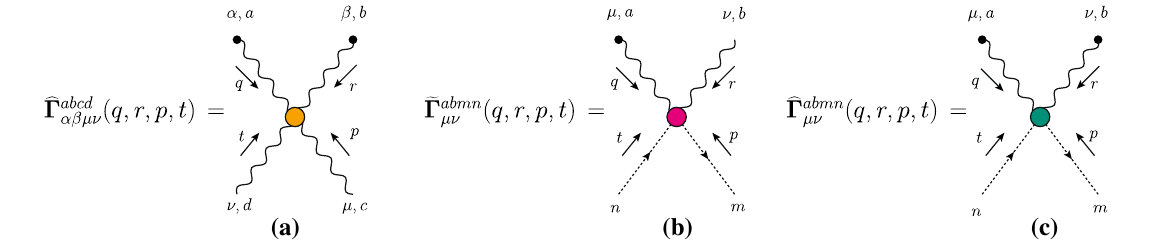
Fig. 2 Diagrammatic representations of the fully dressed four-point functions: a BBQQ, b BQ ¯ cc, and c BB ¯ cc. Notice that all momenta are incoming, i.e., q + r + p + t = 0, and we have factored out − ig 2 following the definitions of Eq. (2.9)